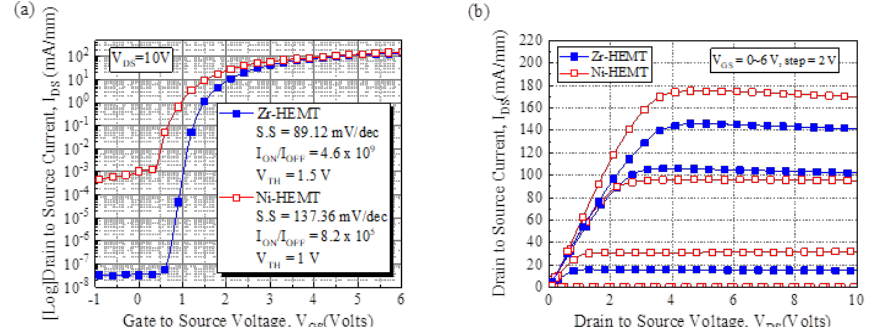
Figure 3. ( a ) Log-scale I DS − V GS transfer and ( b ) I DS − V DS output characteristics of the Zr-HEMT and Ni-HEMT. In this letter, the valence band of Zr and Ni contact to p-GaN were simulated at off-state, which V GS = −2 V and V DS = 100 V by TCAD in Figure 4a,b. The low work function metal Zr contact to p-GaN